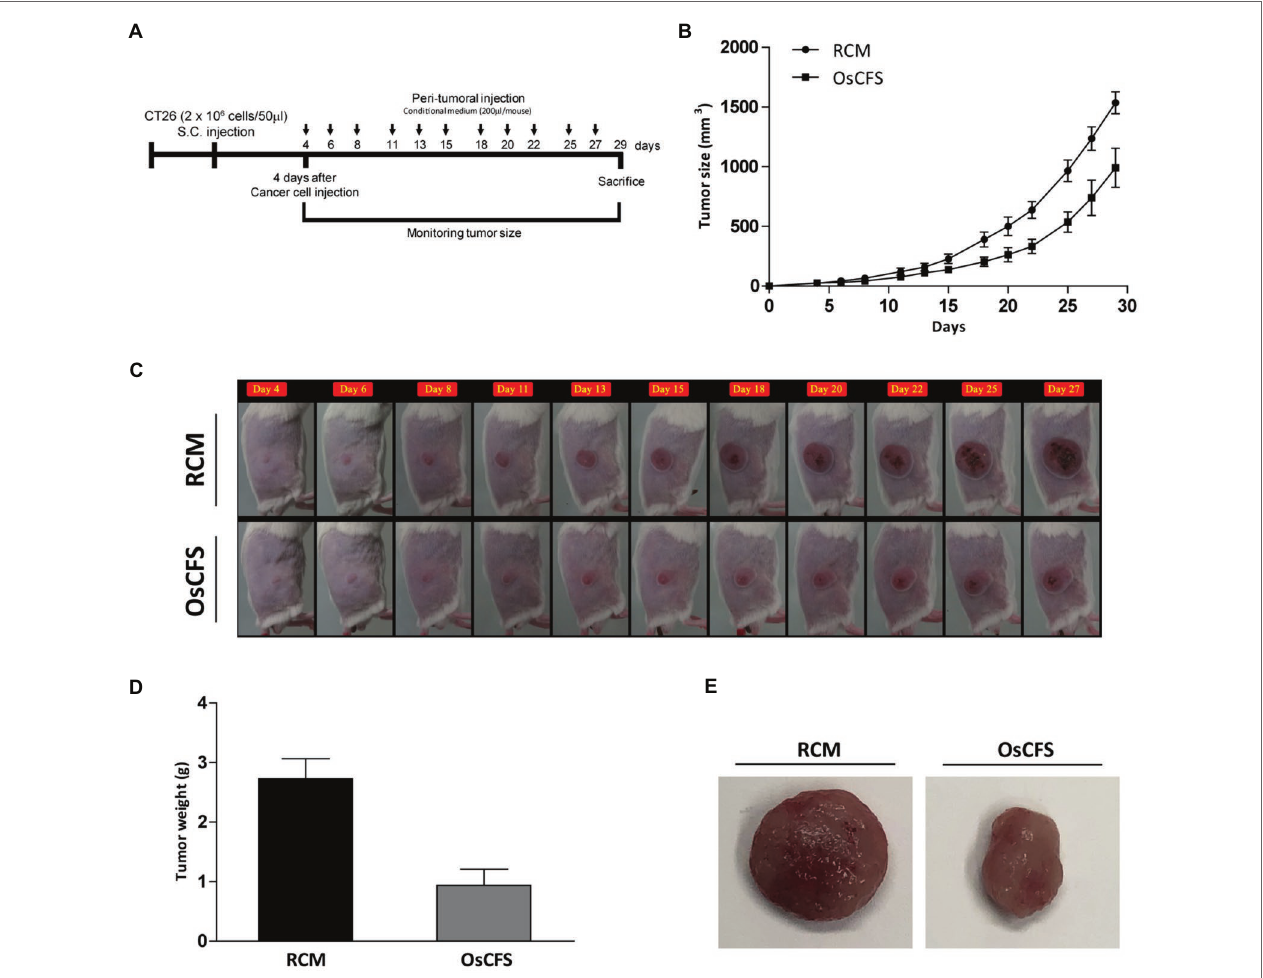
FIGURE 5 | Inhibitory effect on colonic tumorigenesis of the Odoribacter splanchnicus cell-free supernatant (OsCFS) in a murine allograft model of CRC. Data are expressed as mean ± standard error of these groups (RCM group = 5, OsCFS group = 5). (A) Schematic diagram showing the experimental design of the colorectal cancer murine model. (B,C) Tumor volume of mice treated with control medium or OsCFS during the experiment. (D) Tumor weight of mice treated with control medium or OsCFS at the end of the experiment. (E) Photograph of excised tumors at the end of the